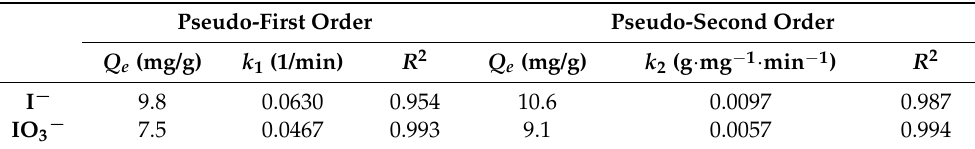
Figure 3. Isotherm adsorption of iodide ions onto C ‐ Cu at ( a ) 20 °C, ( b ) 40 °C, and ( c ) 60 °C and of iodate ions at ( d ) 20 °C, ( e ) 40 °C, and ( f ) 60 °C. C 0 = 10 mg/L, C ‐ Cu dose 0.5 g/L, pH = 7.0 ± 0.2. Table 2. Adsorption kinetic parameters of iodide and iodate ions on C ‐ Cu.